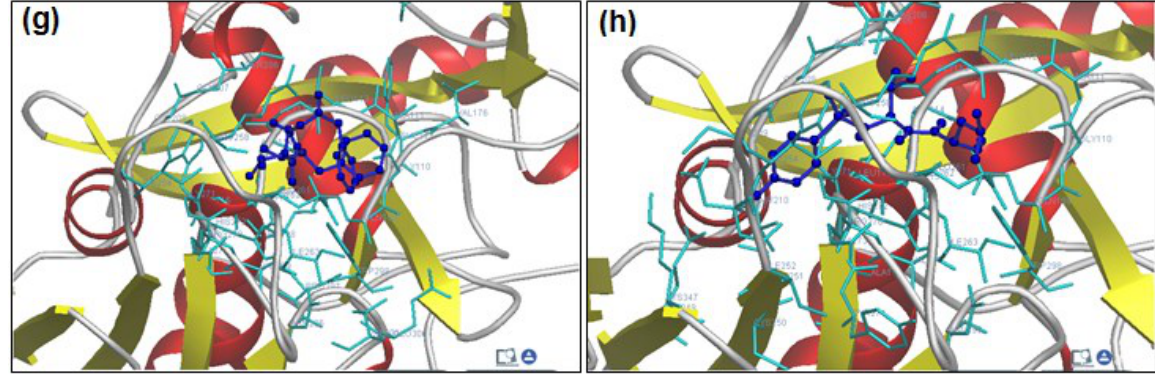
Figure 6. Visualization of the geometrical preferences of the calpain molecule (green secondary structure) in complexation with ligand molecules (yellow tube